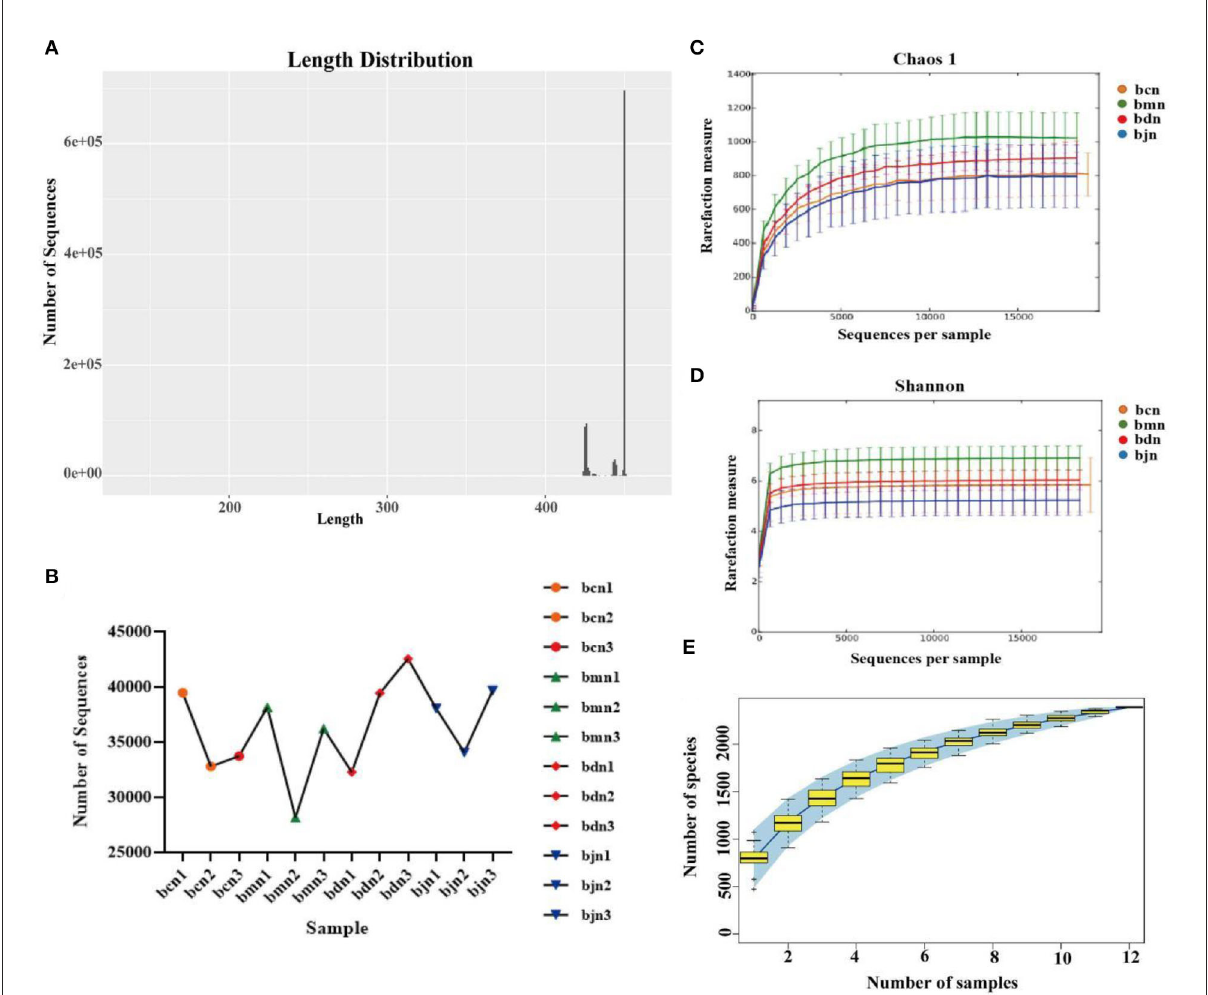
FIGURE3 Sequencing data quality assessment of intestinal contents microbiota. (A) Sequence length distribution diagram. (B) The effective sequence quantity of each sample. (C) Dilution curve of Chaos 1. (D) Dilution curve of Shannon. (E) Species accumulation curve. bcn: